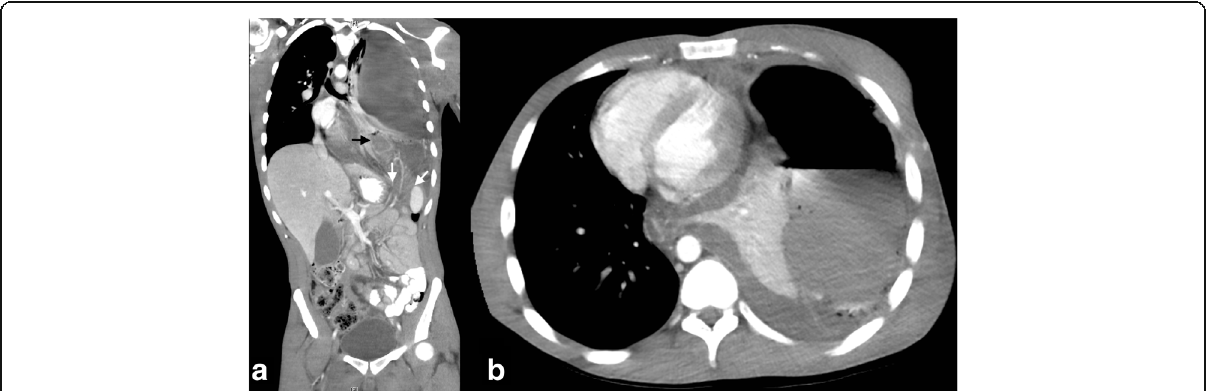
Fig. 1 Computed tomography. a Coronal view demonstrating hernia of diaphragm containing large bowel and a complex hydropneumothorax of the left thoracic cavity consistent with perforation of the herniated bowel causing faecopneumothorax. Black arrow points to a loop of large bowel within the thoracic cavity, and white arrows point to the diaphragmatic hernia defect. b Axial view demonstrating collapse of the left lung due to the complex hydropneumothorax and contralateral mediastinal shift